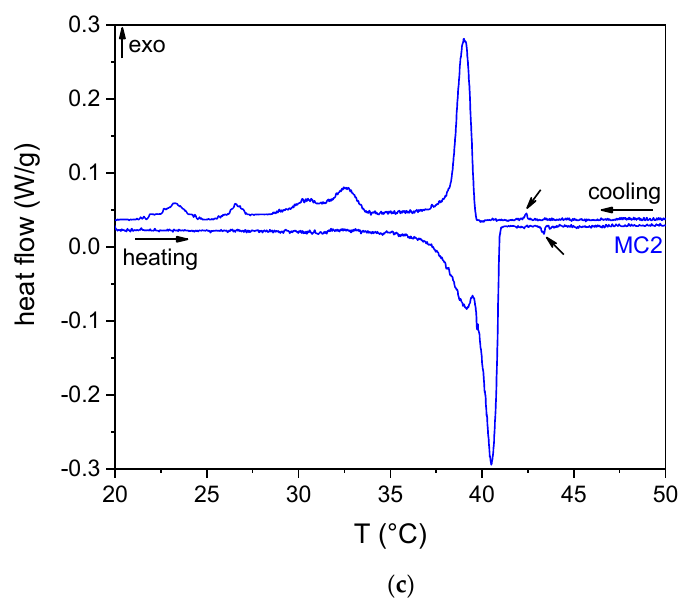
Figure 6. ( a ) DSC thermograms of the bulk (D) and microencapsulated (MC1 and MC2) docosane and the neat organosilica microparticles (Si). The first heating scans and the cooling scans are reported. ( b ) DSC thermogram of the neat docosane acquired at 0.2 °C/min (heating and cooling scan). ( c ) DSC thermogram of the microcapsules MC2 acquired at 0.2 °C/min (heating and cooling scan). Table 3. Main results of the DSC tests on the bulk (D) and microencapsulated (MC1 and MC2) docosane. The table reports data of the phase change temperatures and enthalpies, as well as the encapsulation efficiency.